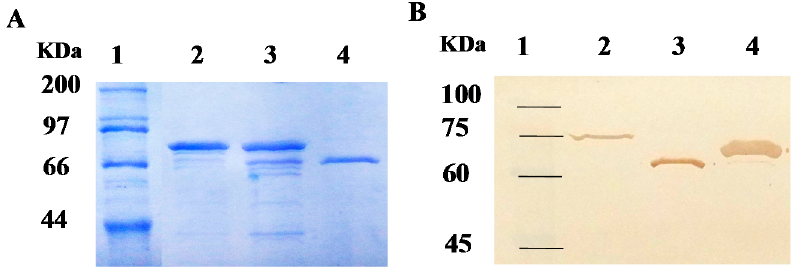
Figure 3. SDS-PAGE and Western blot analysis of expression and purification of recombinant 001D. ( A ) The samples were separated on 12% gels; and ( B ) Western blot analysis of recombinant carboxylesterase using anti-His tag antibody. Lane 1 : Protein ladder, Lane 2 : purified Trx/6×His/S-tag/001D from pET32a, Lane 3 : purified 6×His-tag/001D from pE1, Lane 4 : purified 6×His/S-tag/001D from pET30a.